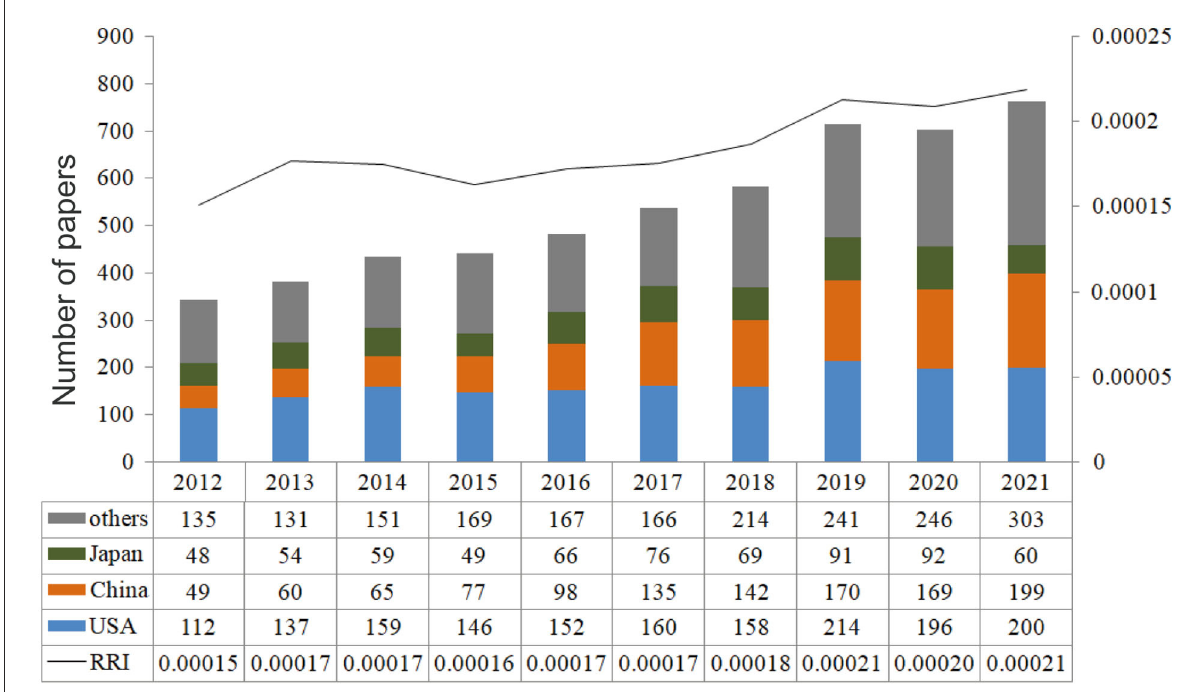
FIGURE2 The number of publications of the top three prolific countries across time, and the time course of relative research interest of IA.